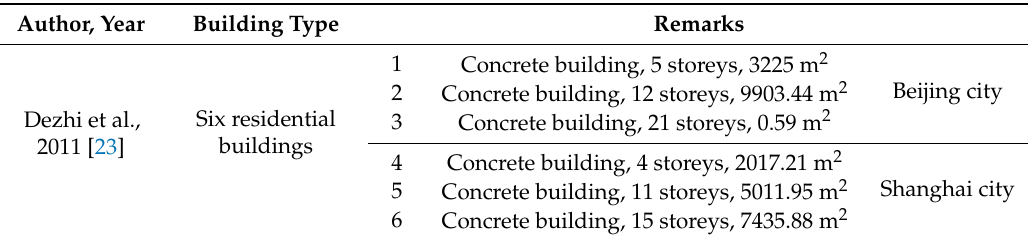
Table 1. Emergy analysis of building construction in